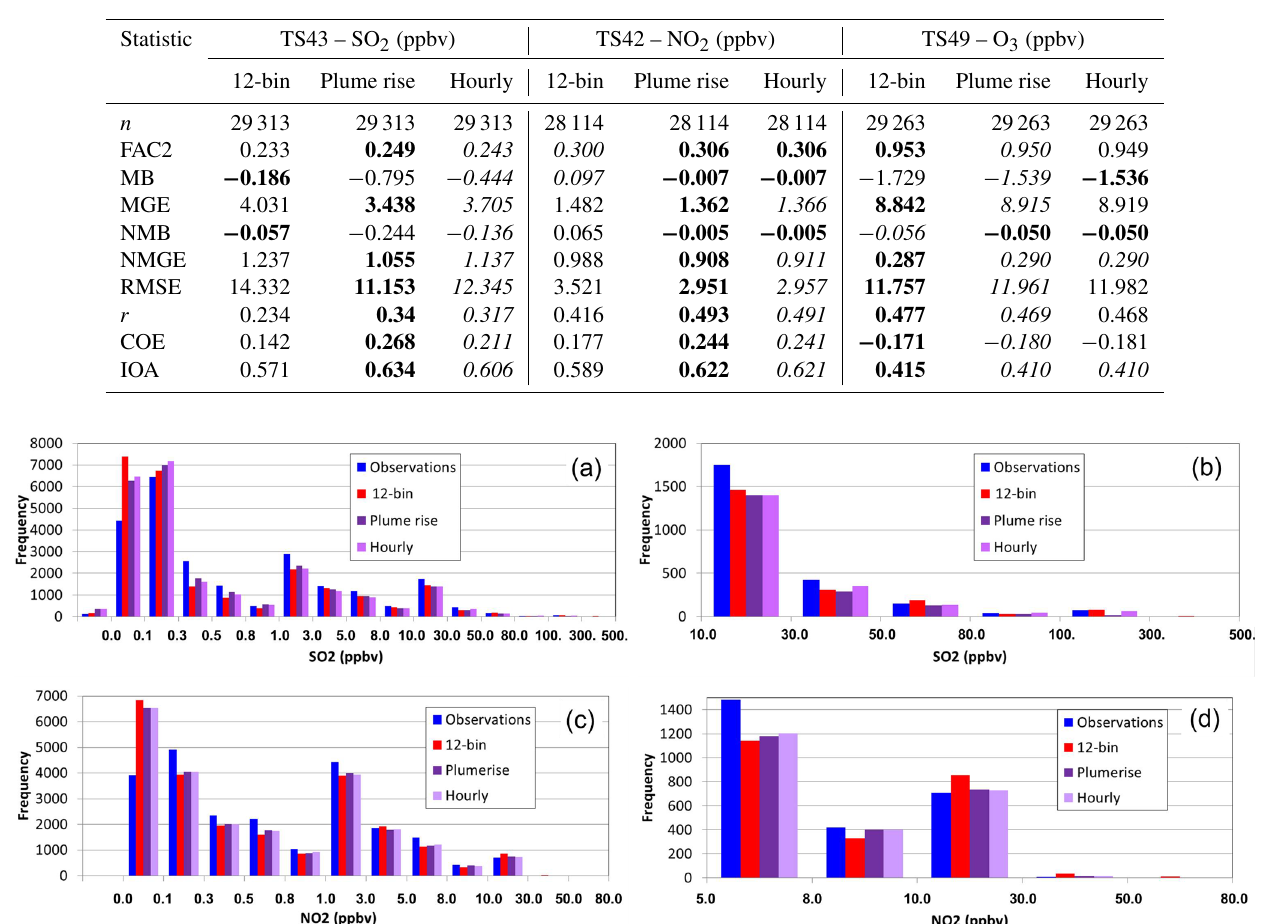
Figure 5. Histograms comparing SO 2 and NO 2 simulations mixing ratios (ppbv) with aircraft observations. (a) All SO 2 values. (b) Higher SO 2 mixing ratios. (c) All NO 2 values. (d) Higher NO 2 mixing ratios. Leftmost histogram bin in panels (a) and (c) correspond to values of